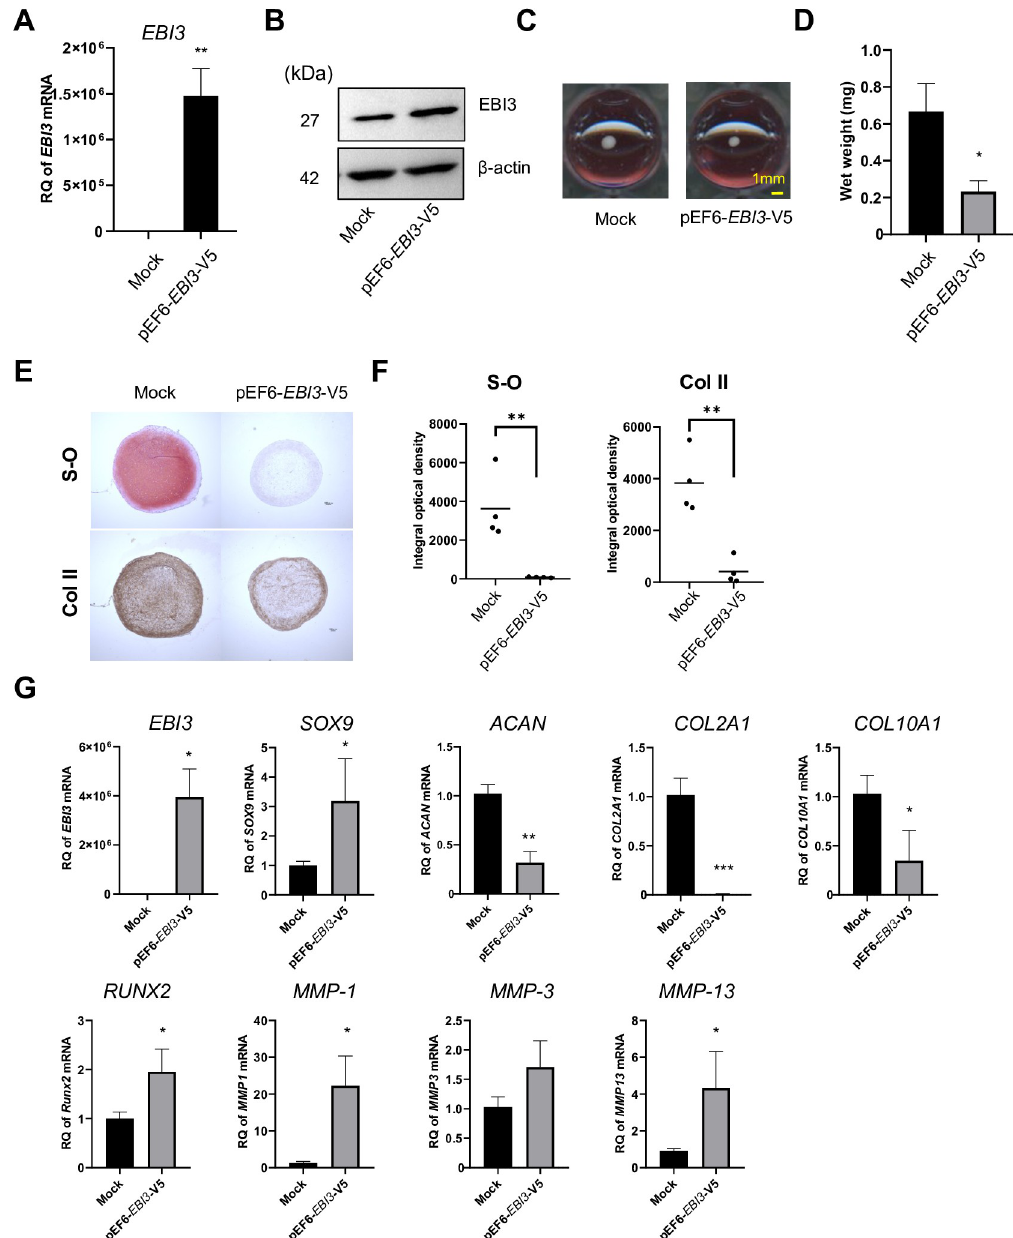
Fig 3. EBI3 overexpression in MSCs inhibits chondrogenic differentiation. (A-G) MSCs were transiently transfected with pEF6- EBI3 -V5 plasmid DNA. (A) EBI3 mRNA levels were evaluated by RT-qPCR at 24 hrs after transfection. (B) EBI3 protein levels were evaluated by western blotting at 72 hrs after transfection. β -actin was used as a loading control. (C-G) MSCs were cultured as pellets in chondrogenic medium for 21 days after transfection with pEF6- EBI3 -V5 or empty vector. (C) Photographs of the pellets. Scale bar, 1mm. (D) Wet weight of the pellets. (E) Aggregates were stained with Safranin O (S-O) or anti-type II collagen (Col II) antibody. Scale bar, 100 μ m. Results are representative of 4 independent experiments with similar findings. (F) Densitometric analysis of the stained of (E) was performed and shown by integral optical density (IOD). (G) The mRNA levels of the indicated genes between transfected aggregates were determined by RT-qPCR on day 21. (A, D, F, and G) Quantified data are expressed as the mean ± SD with similar findings (each n = 3 in A, D, and G; n = 4 in F). � = P < 0.05; �� = P < 0.01; ��� = P < 0.001 by Student’s unpaired 2-tailed t-test.